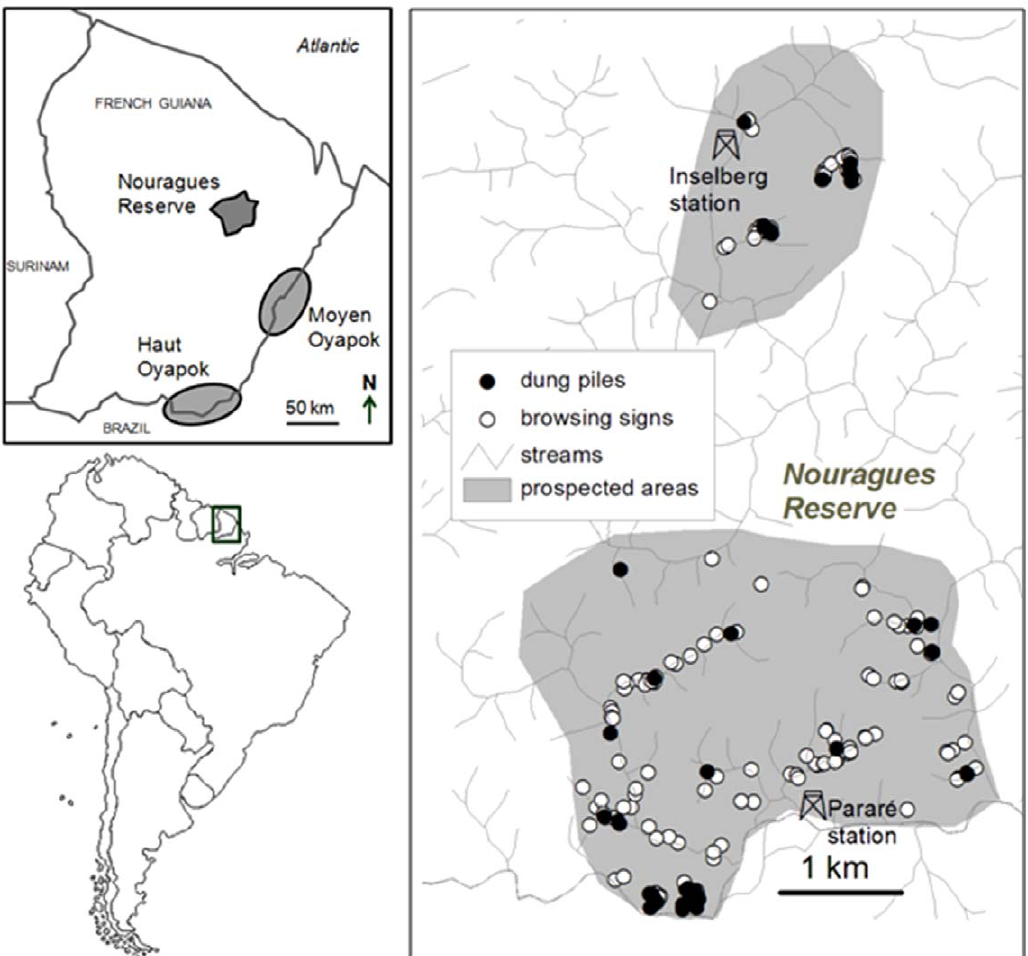
Figure 1. Location of the study areas and sites where tapir browsing signs and dung piles were collected.